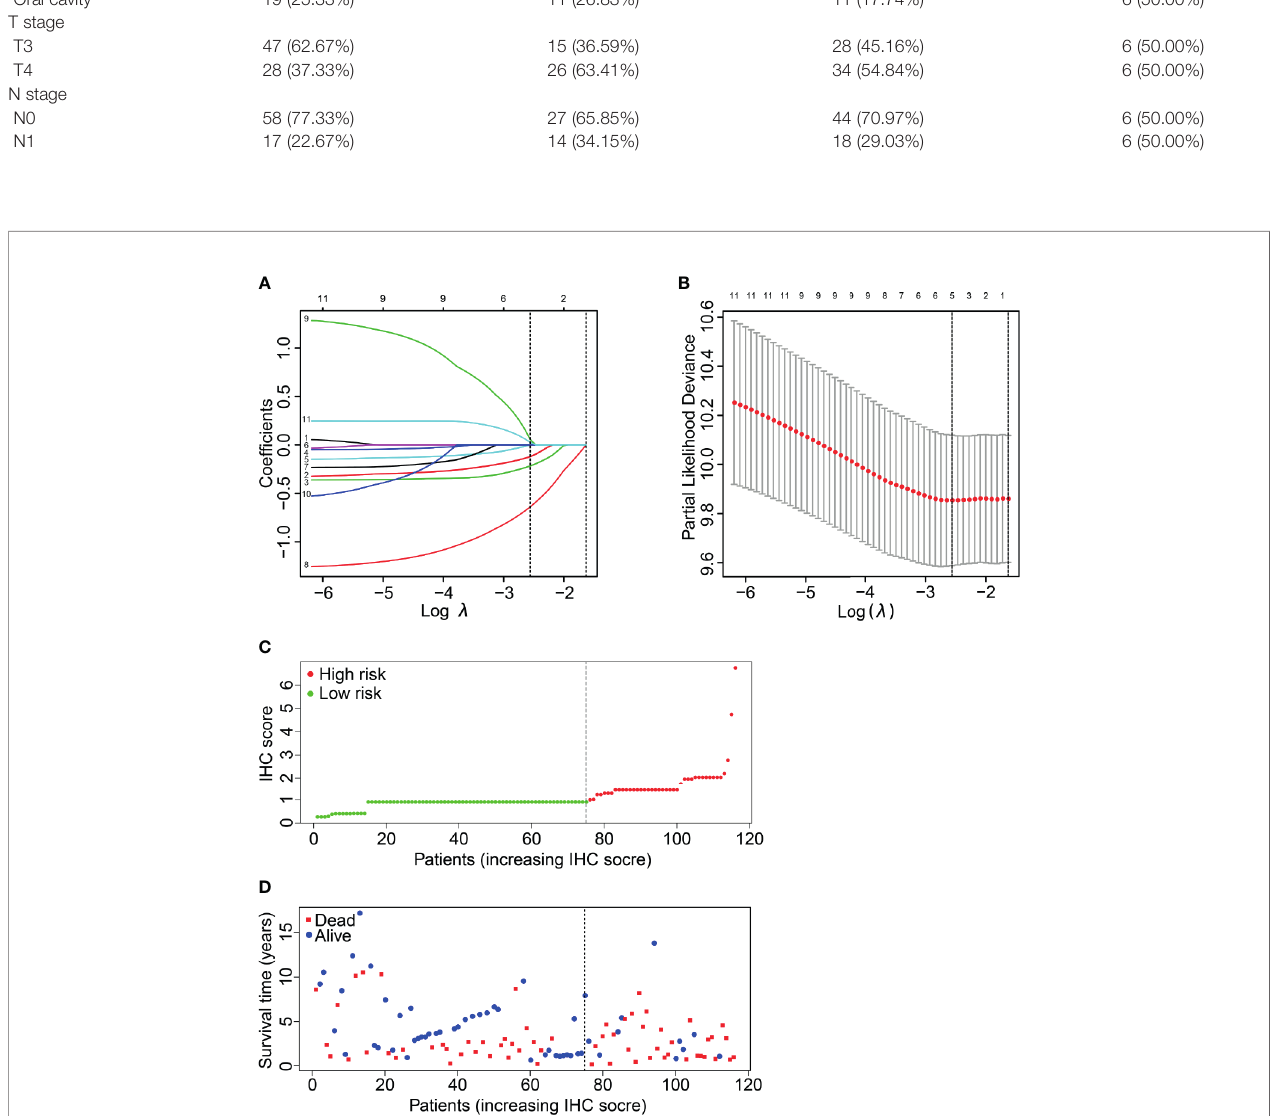
FIGURE 2 | IHC feature selection using the LASSO cox regression model. (A) A LASSO coef fi cient pro fi le plot of the IHC features was produced against the log l sequence. (B) Ten-fold cross-validation for IHC features selection in the LASSO Cox model. The dotted vertical lines represented the l values with minimal deviance (left) and with the largest l value within one standard deviation of the minimal deviance (right). We then selected the coef fi cients of the model with the minimal deviance, which included 5 IHC features. (C, D) The IHC score classi fi ed MMHN patients into low-risk and high-risk